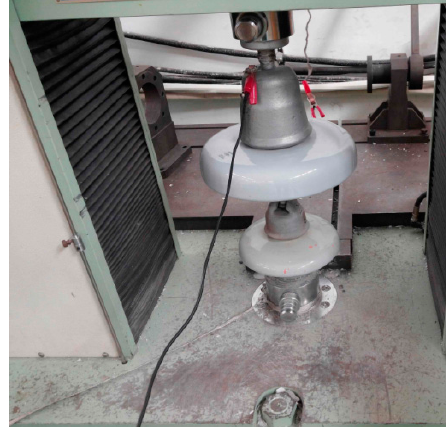
Figure 2. Experimental set up for tensile load test.